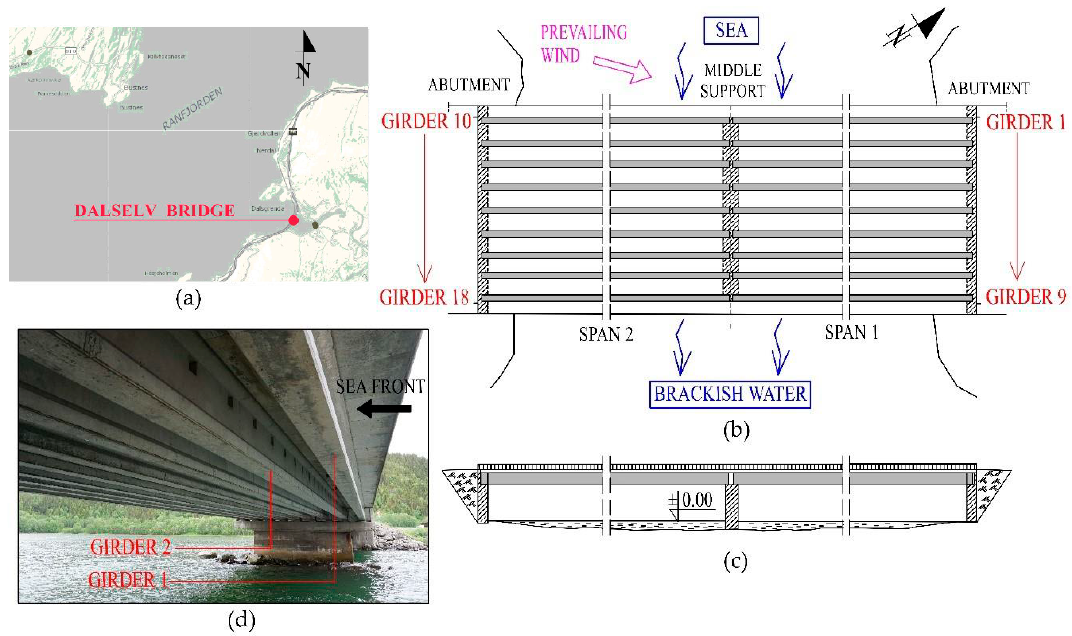
Figure 1. Dalselv Bridge: ( a ) bridge location; ( b ) bottom view; ( c ) side view; ( d ) photo taken underneath the bridge, facing south.